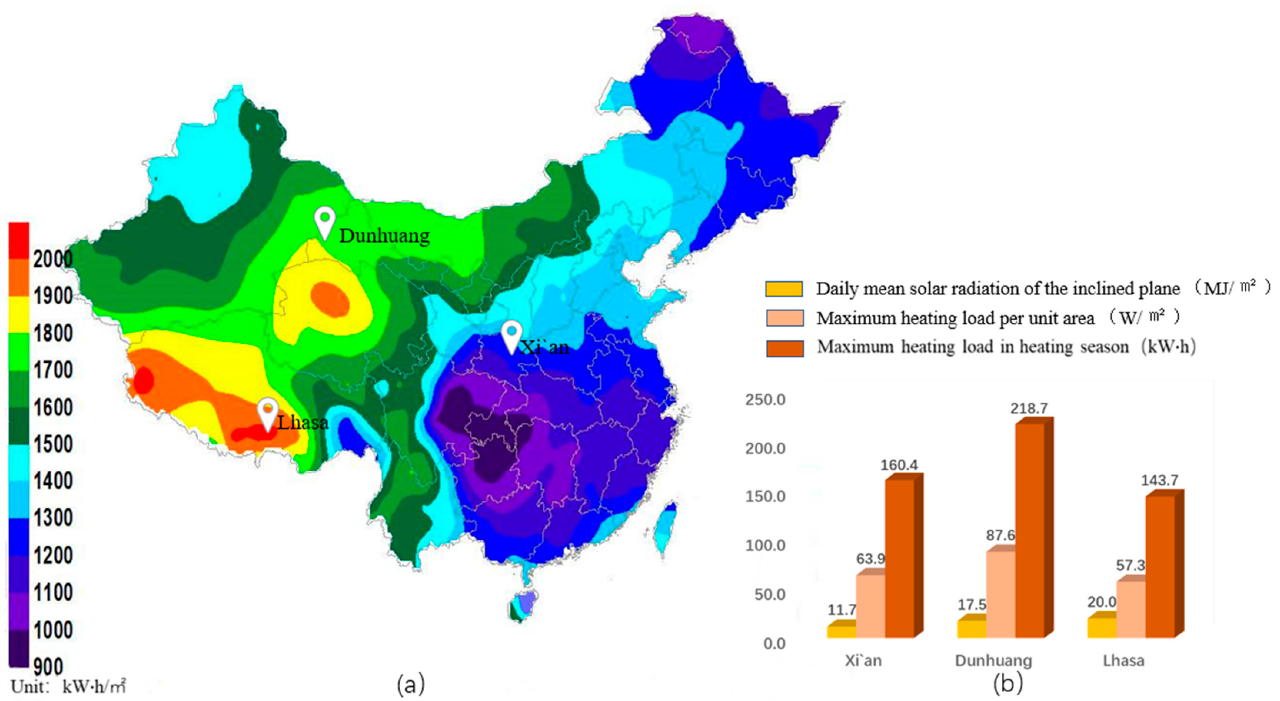
Figure 2. ( a ) Distribution map of total annual solar radiation in China; ( b ) daily average solar radiation and heating load on slope.